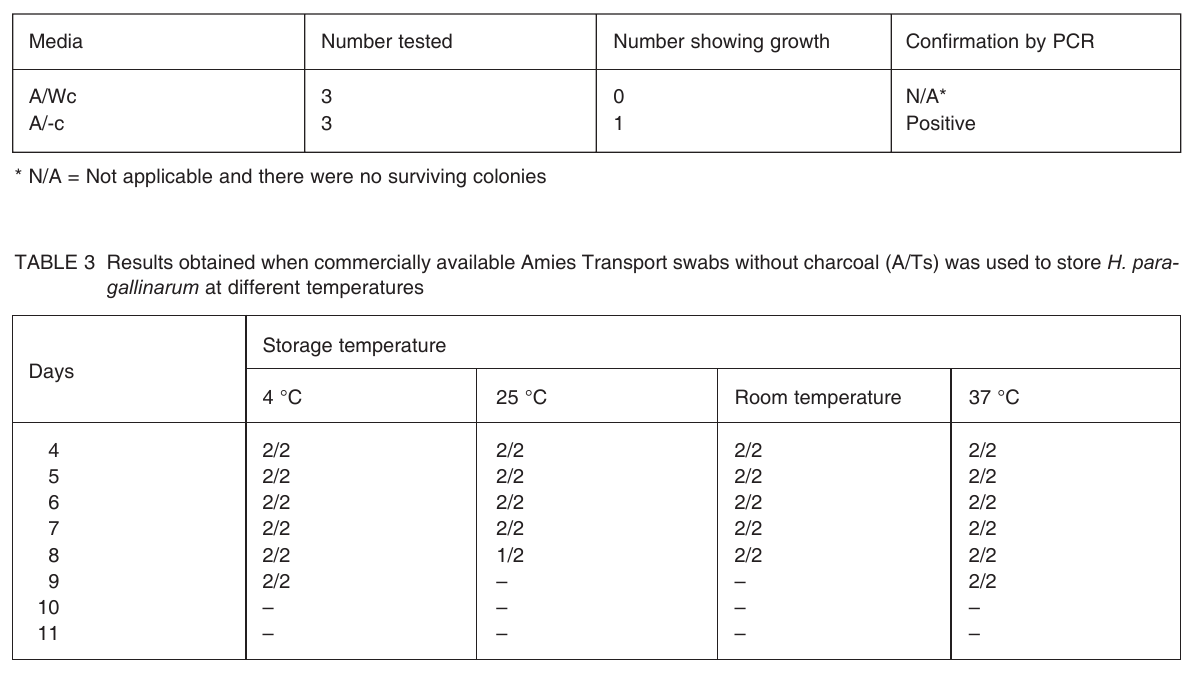
TABLE 2 Growth after revival of H. paragallinarum streaked onto plates of Amies Transport Medium with (A/Wc) and without (A/-c) the addition of charcoal after 4 days’ incubation at 37°C